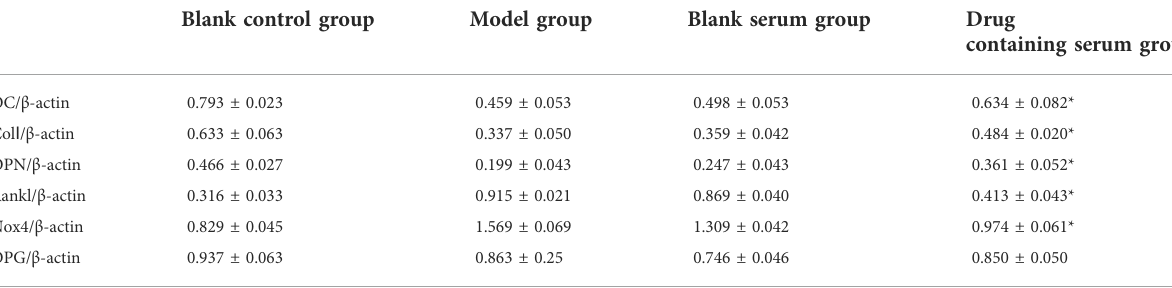
TABLE 4 Continuous static pressure damage model index WB detection ( n =